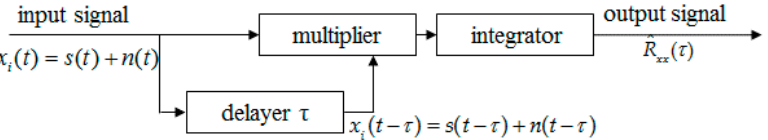
Figure 5. Schematic of autocorrelation detection.